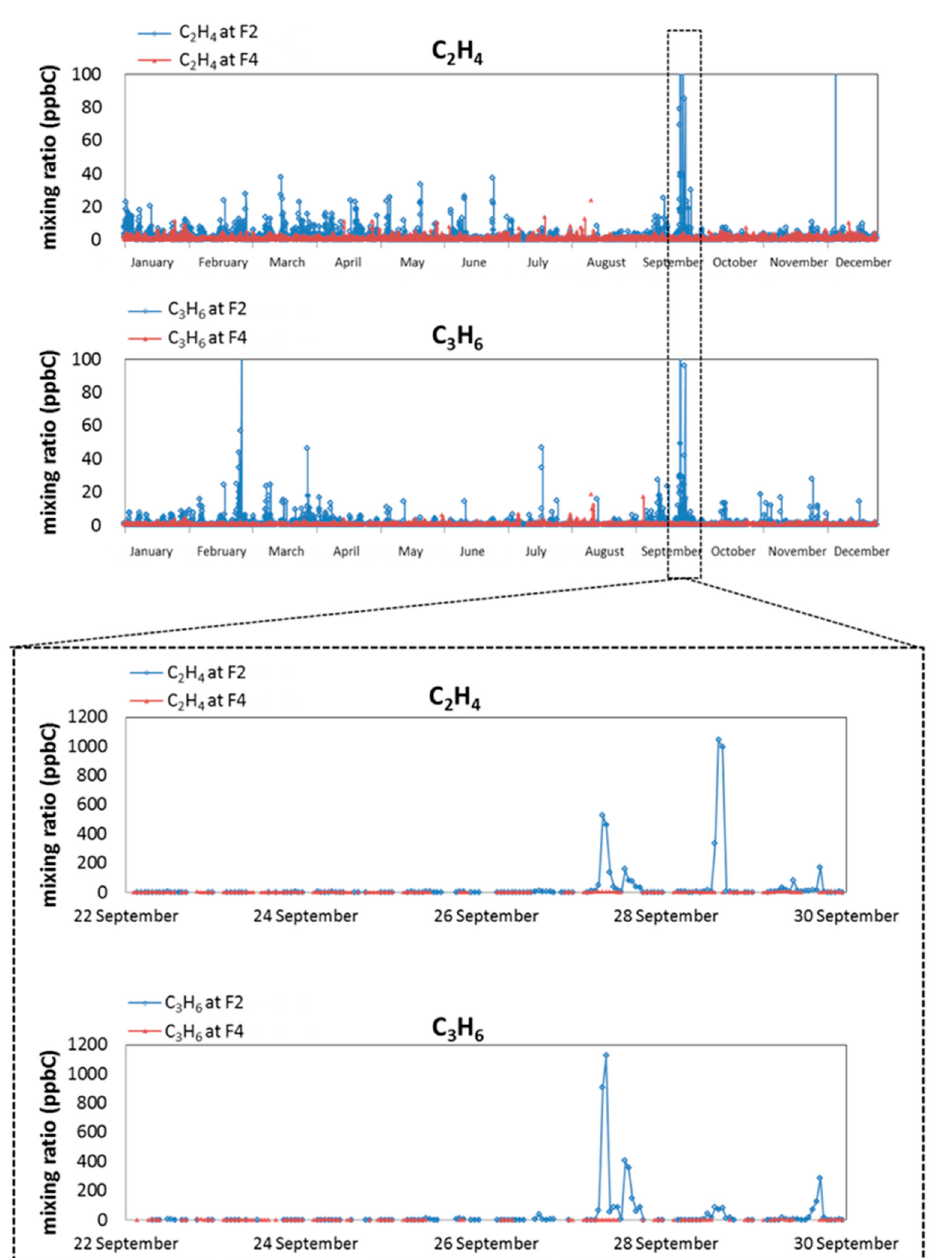
Figure 4. Plumes appeared as tall spikes of ethene and propene observed at F2 and F4 PAMS sites. The upper two panels are whole year hourly data. The bottom two panels are the enlargement of the September data of 2014.